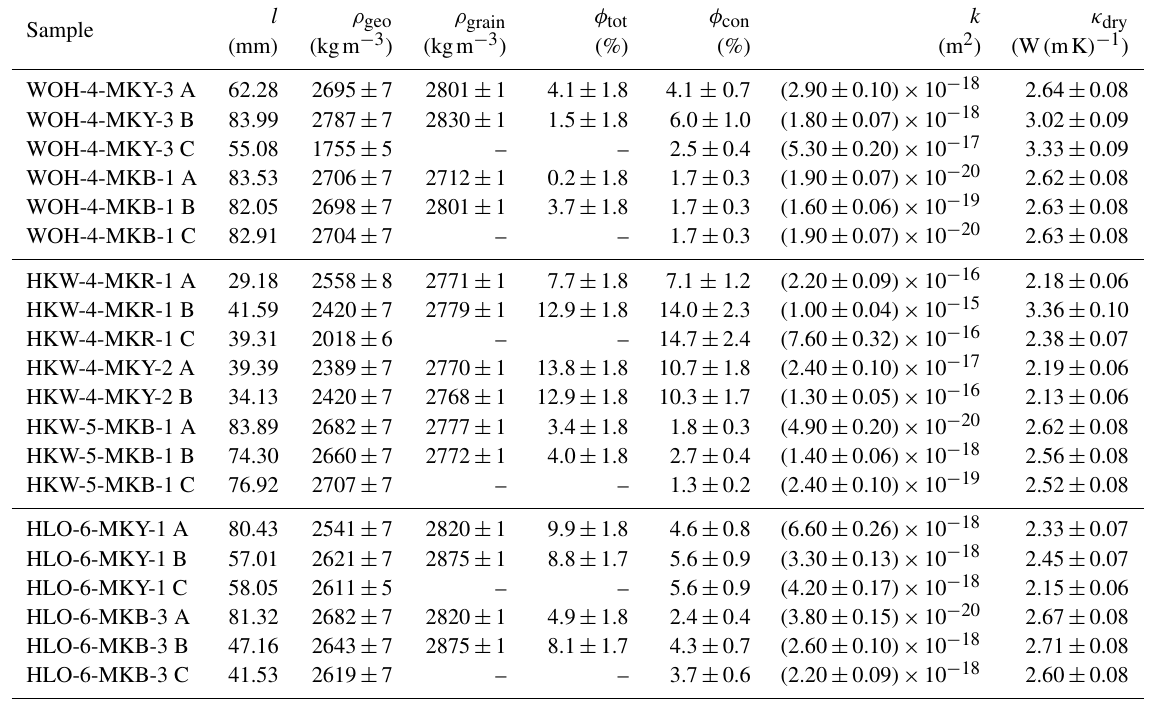
Table 4. Matrix properties, permeabilities, and thermal conductivities as determined by laboratory measurements on limestone and dolomite samples from Wuppertal (WOH), Hagen-Hohenlimburg (HKW), and Hönnetal (HLO). The abbreviations MKY, MKB, and MKR indicate the coloured rock types Massenkalk yellow (dolomite), Massenkalk black (limestone), and Massenkalk red (dolomite), respectively. Sample